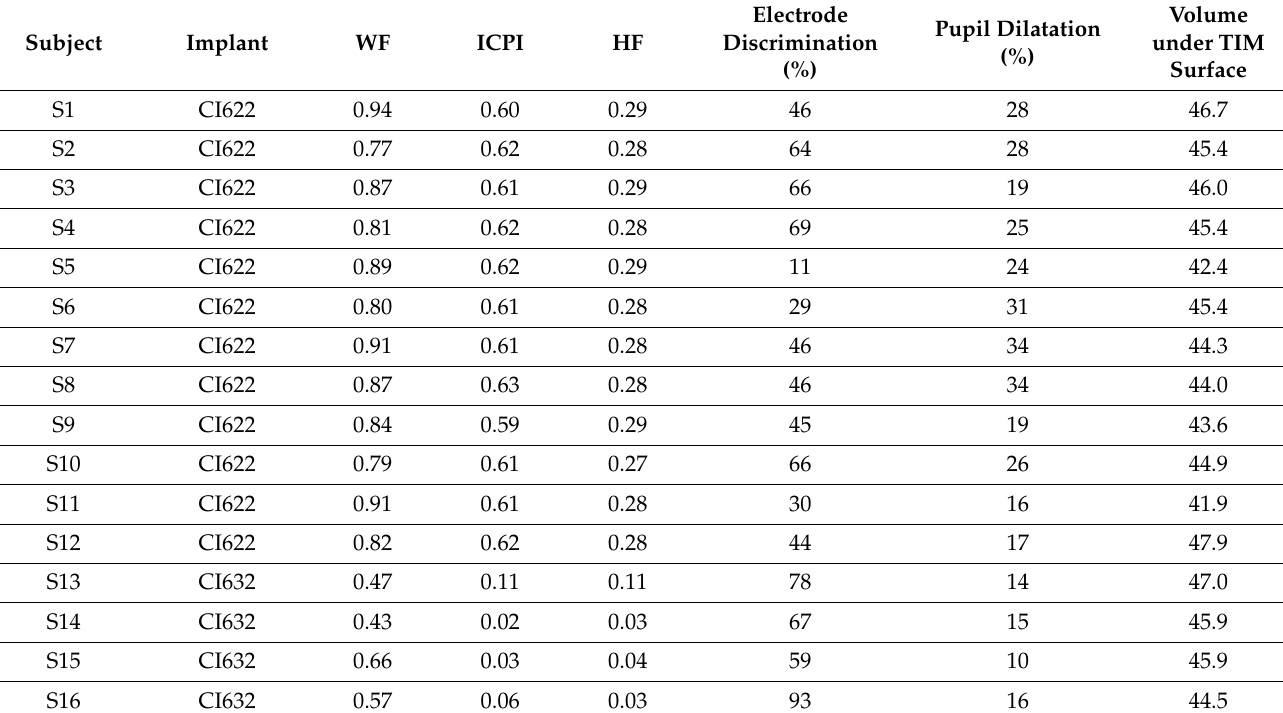
Table 2. Correlation for radiological, electrode discrimination, pupil dilatation, and volume under the TIM (TransImpedance Matrix) surface results.